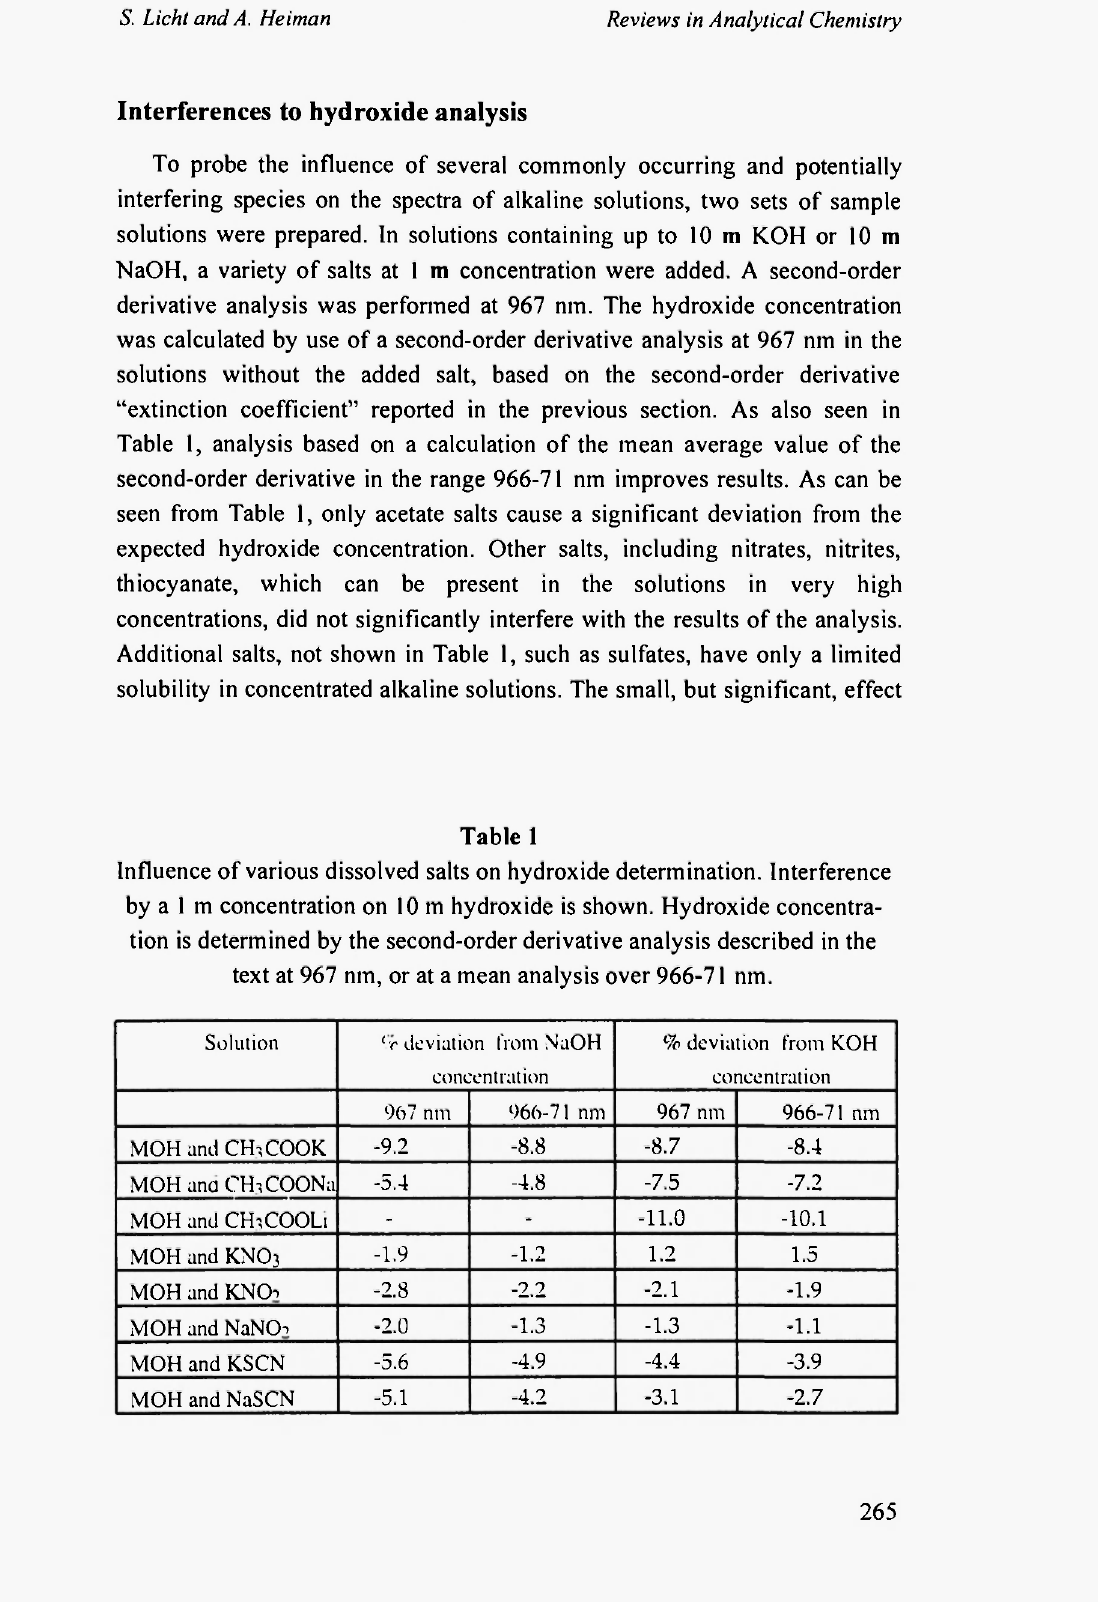
Influence of various dissolved salts on hydroxide determination. Interference by a 1 m concentration on 10 m hydroxide is shown. Hydroxide concentra- tion is determined by the second-order derivative analysis described in the text at 967 nm, or at a mean analysis over 966-71